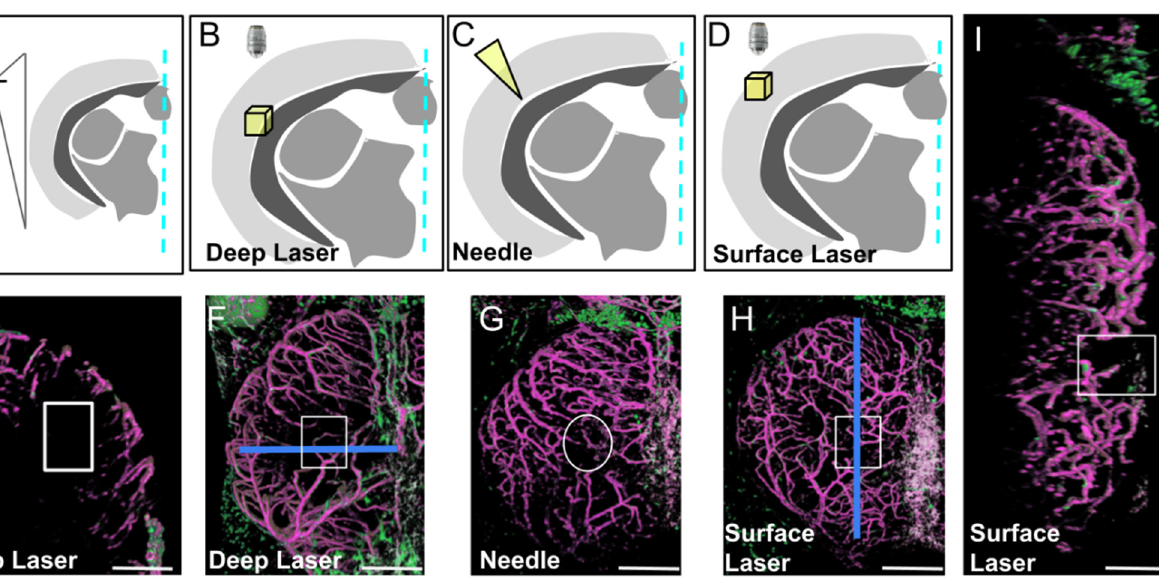
Figure 3. Three types of injury of the optic tectum (OT) at 21 dpf. ( A ). Schematic cross section at the level of the center of the OT with approximate location of details in ( B – D ). ( B , E , F ). Deep biphoton laser injury. ( C , G ). Needle injury. ( D , H , I ). Surface biphoton laser injury. Blue lines in ( F , H ) indicate locations of sections shown in ( E ) and ( I ). ( E , I ). Cross and parasagittal sections showing locations of wounds (white rectangles). ( F – H ). Dorsal views with location of injuries (white squares and circle). Anterior at the top. Midline on the right. Scale bars: ( E – I ): 100 µm.